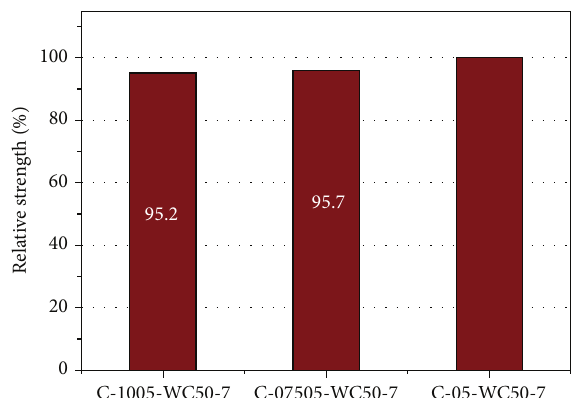
Figure 7: Compressive strength for different concentration control methods.